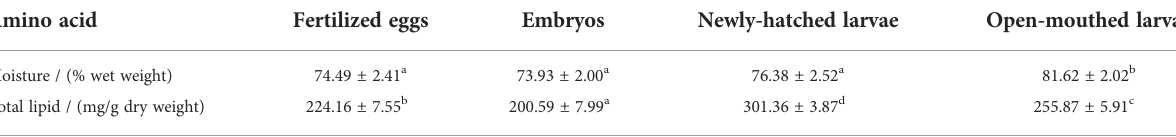
TABLE 3 The moisture and total lipid content of cobia in different developmental stages (n=3). Amino